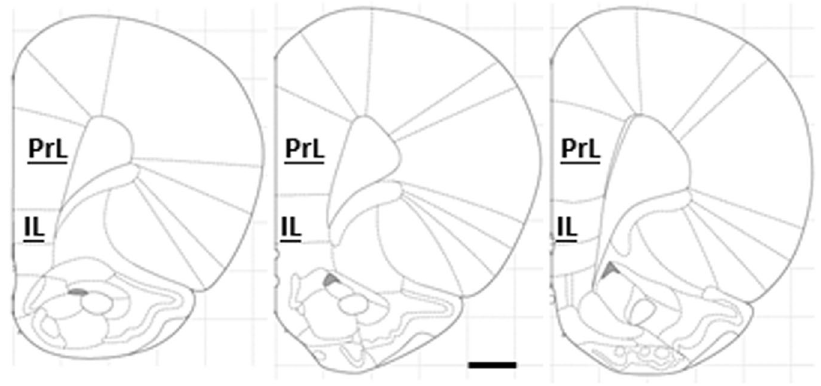
Figure 1. Anatomical bounds of prelimbic (PrL) and infralimbic (IL) cortex used for sampling of the dendritic trees. Only one hemisphere is depicted, at coronal planes of bregma 3.72 mm, 3.24 mm and 3.00 mm (left to right). Outlines adapted from 46 . Scale bar = 1